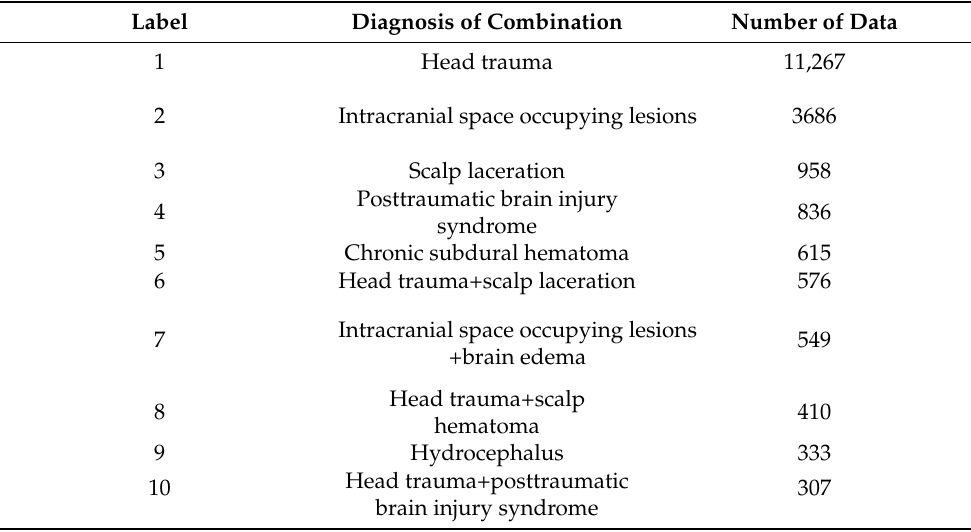
Table 4. The first ten categories after transformation by LP method.